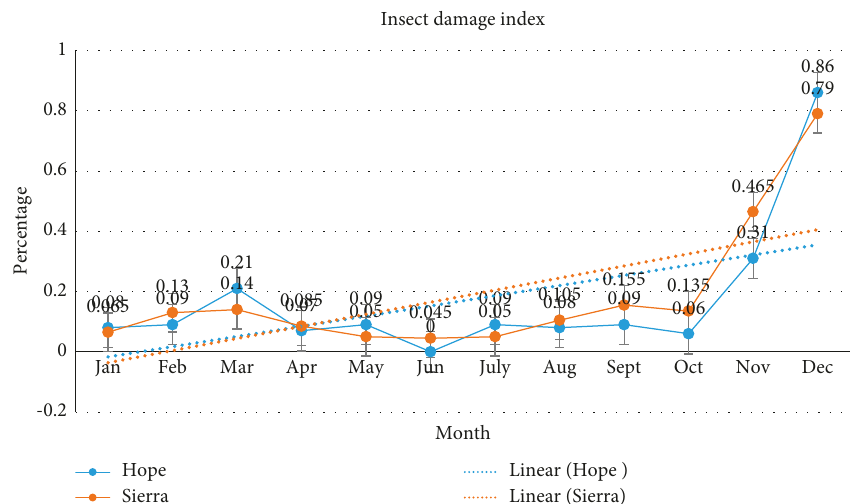
Figure 10: Comparison of the insect damage index trends for Hope and Sierra malting barley varieties over the 12-month storage